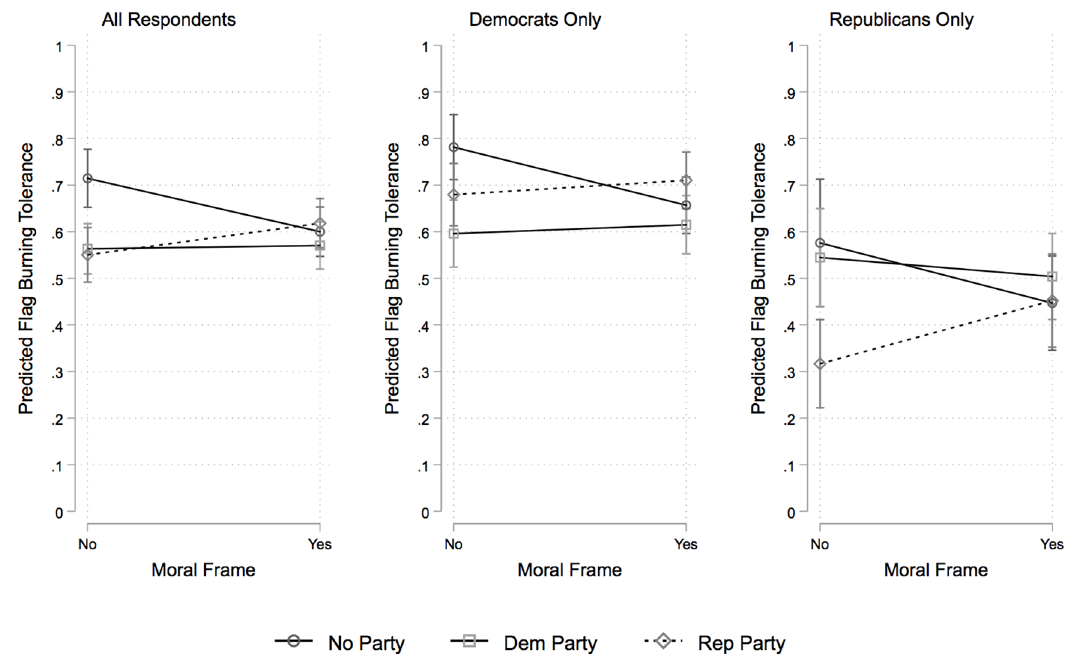
Figure 2. Experimental treatment effects on flag burning tolerance (Study 2). Note. Open dots represent the estimated predicted values for tolerance of speech in each of the flag burning speech conditions plus control condition, with 95% confidence interval bars. All estimates are derived from OLS regression models that employ a factorial design (see Table 2). Estimates for "All Respondents" are derived from the 2x3 factorial design without demographic controls estimated in Table 2, Column 1. Estimates for "Democrats Only" and "Republicans Only" are derived from the 2x3x2 factorial design without demographic controls estimated in Table 2, Column